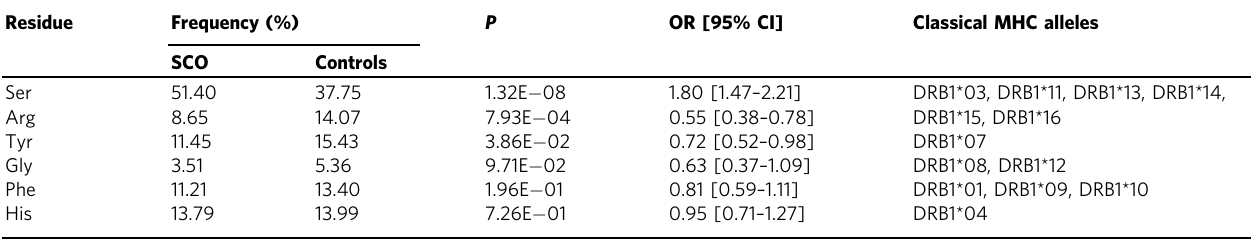
Table 2 Effect on the susceptibility to Sertoli cell-only (SCO) phenotype of the residues at position 13 of the HLA-DR β 1 molecule.